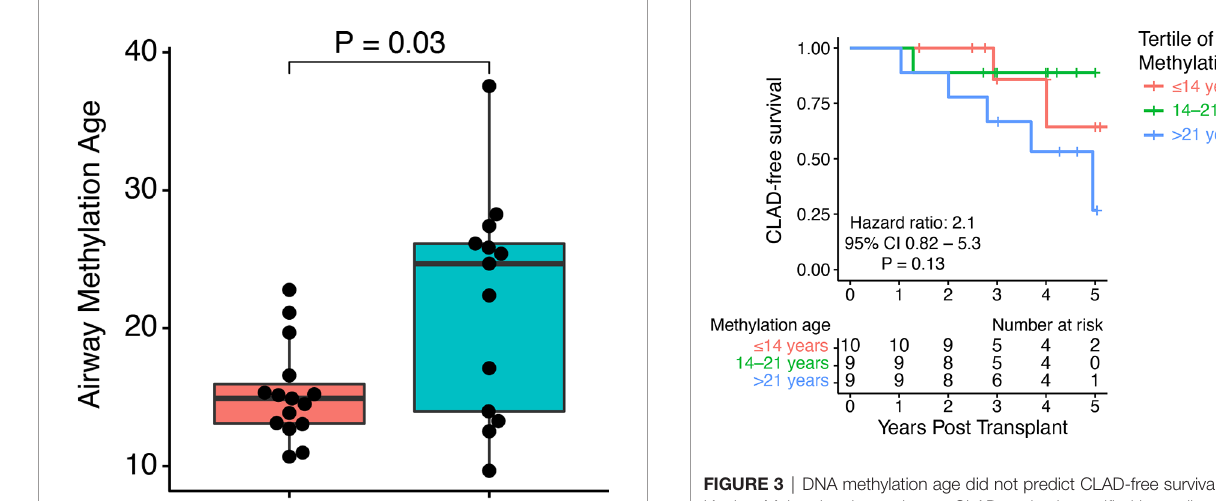
FIGURE 3 | DNA methylation age did not predict CLAD-free survival. A Kaplan – Meier plot shows time to CLAD or death strati fi ed by tertiles of airway methylation age. The hazard ratio for CLAD or death was 2.1 (95% CI 0.82 – 5.3) per tertile of airway methylation age determined by Cox proportional hazards